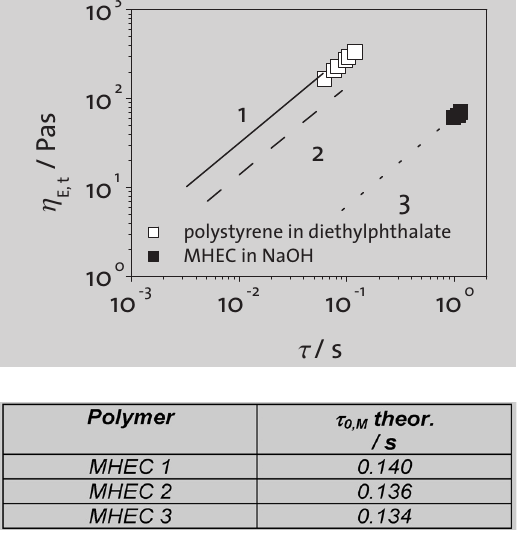
Fig. 11 (above): Comparison of two distinct h E,t / t 0 dependencies for flexible (1) resp. rigid like behaviour (2) according to Stelter et al. to experimental data. Table 8 (below): Longest relaxation times evaluated according to Eq.7 for the investigated MHECs